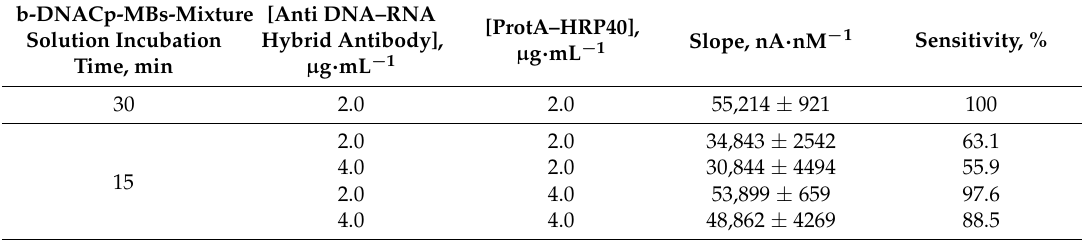
Table 4. Sensitivity obtained for different working conditions checked in the assessment of assay time